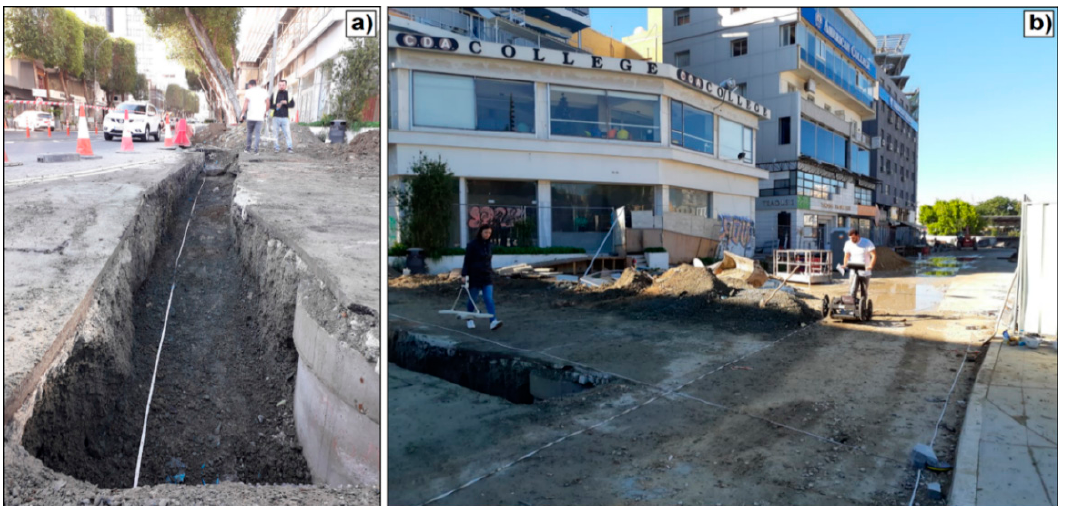
Figure 12. Corner between Evagorou Avenue and Omirou Avenue: the excavated trench ( a ), GPR and